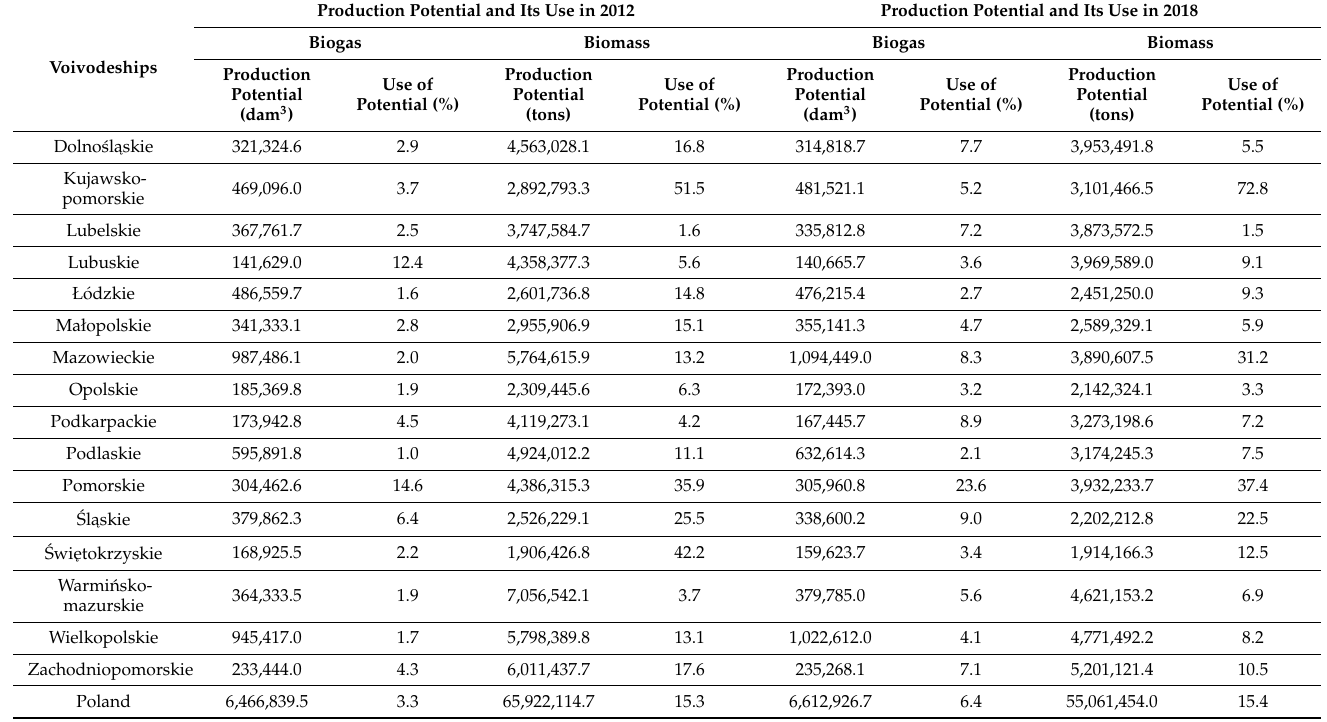
Table 1. Regional differentiation of potential of biogas and biomass production and use in 2012 and